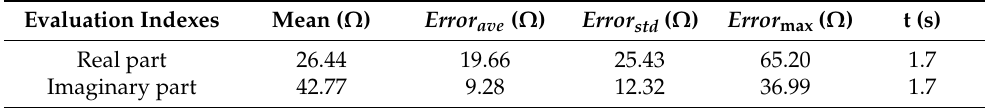
Figure 18. Results of method 2 in 3rd harmonic. ( a ) Result of real part; ( b ) Result of imaginary part. Table 5. Evaluation indexes of method 2 in 3rd harmonic.